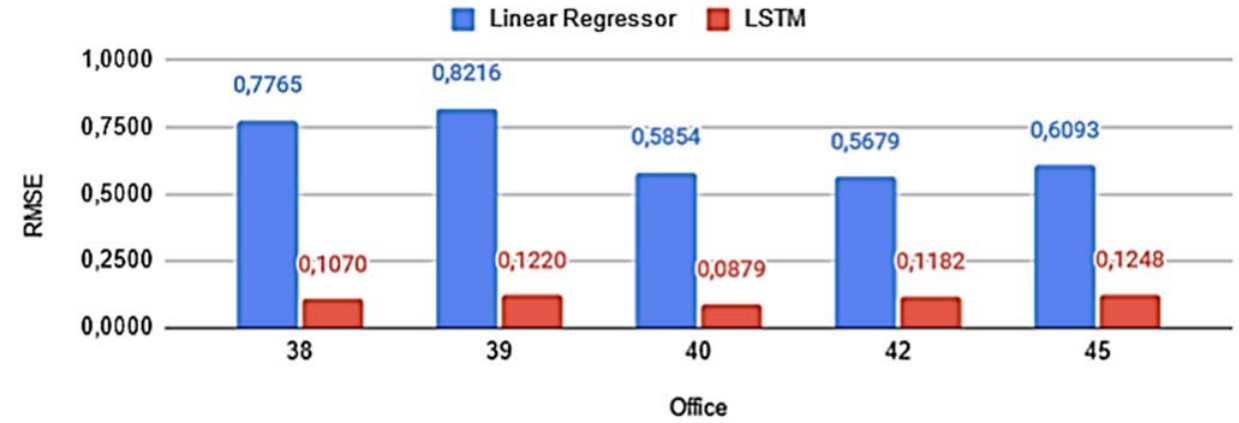
Figure 6. Comparison or RMSE achieved using linear regressor or LSTM neural networks by the office. The error is computed on the validation set only, for a 2 h time horizon.